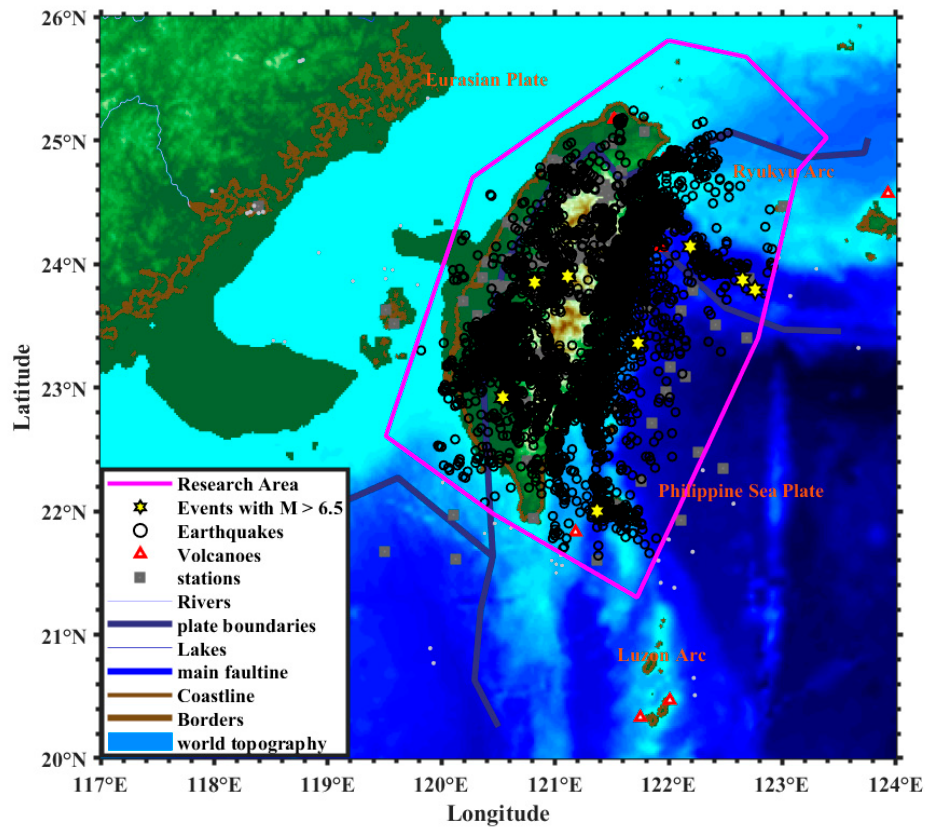
Figure 1. Topographic map of the sea floor around Taiwan. The area outlined in pink is the study